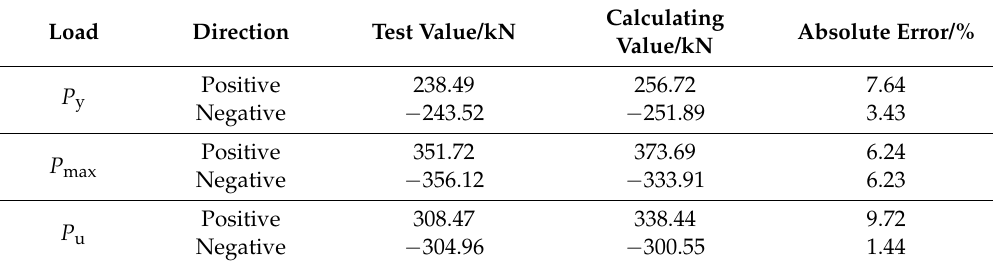
Table 4. Comparison of characteristic value.